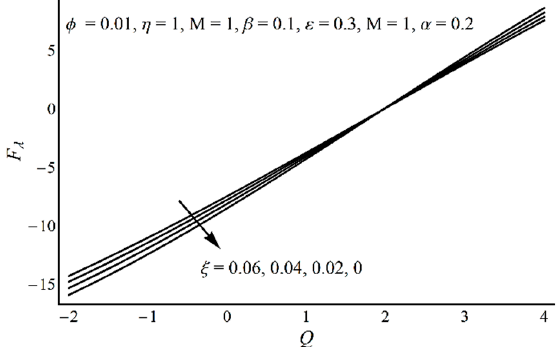
Figure 29. Variations in fluid frictional forces at various ξ .